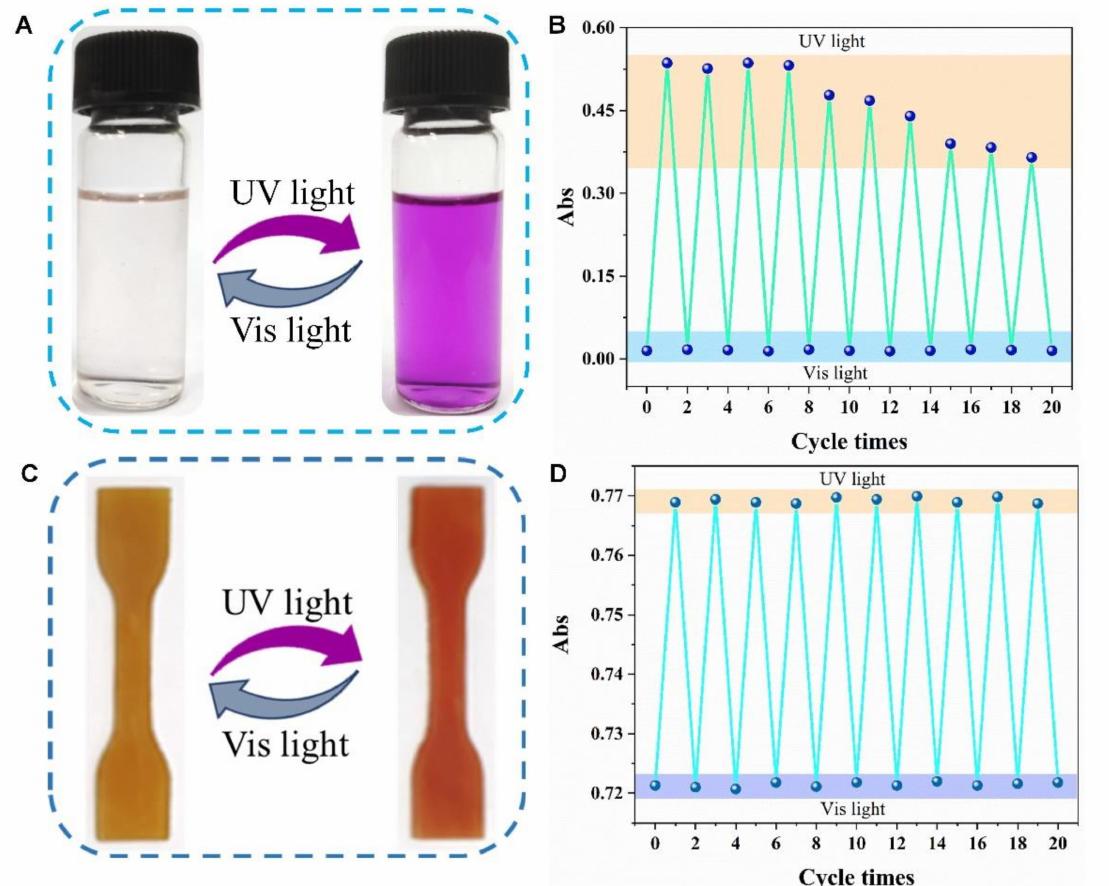
Figure 7. ( A ) The photograph for photoresponse reversibility of HOOC-SP-COOH/ethanol solution, ( B ) the fatigue resistance of HOOC-SP-COOH/ethanol solution, ( C ) the photograph for photoresponse reversibility of SP-PA6-3 and ( D ) the fatigue resistance of